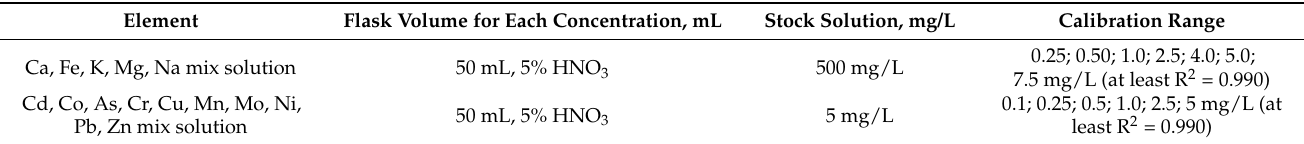
Table 7. Concentration values of standard solutions prepared for MP-AES analysis.